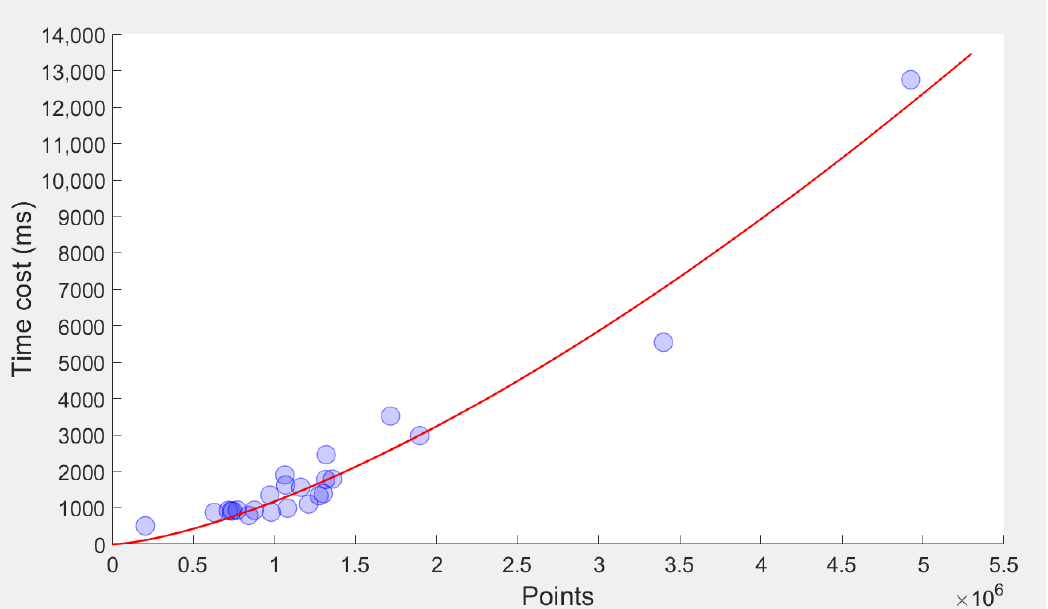
Figure 13. The relationship between the time cost and the number of tree points. The red line is the fitting curve based on the cerulean circles that represent the time cost of each tree.